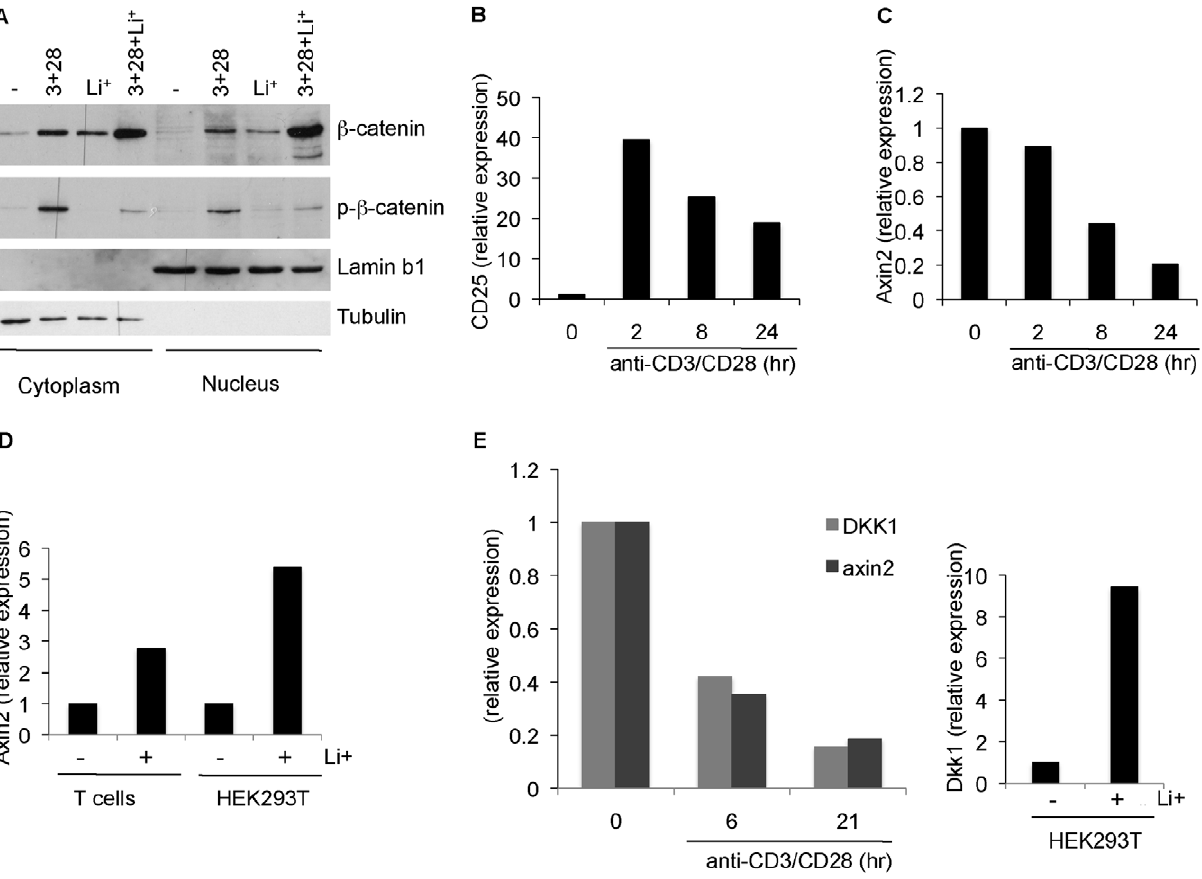
Figure 4. TCR stimulation leads to nuclear translocation of b -catenin. (A) T cells were stimulated with plate bound anti-CD3/CD28 in the presence or absence of 20 mM LiCl for 18 hours, as indicated, following which cytoplasmic and nuclear fractions were separated. Fractions were immunoblotted for b -catenin and phospho- b -catenin expression. Cytoplasmic and nuclear fractionation was confirmed by tubulin (cytosol) and lamin-B1 (nuclear) expression. (B) T cells were stimulated with anti-CD3/CD28 magnetic beads for the indicated times. CD25 (IL-2R a ) mRNA levels were measured by qRT-PCR, using Abl1 as an internal control, to verify successful T cell activation. (C) The expression of the TCF/ b -catenin target gene Axin2 was measured by qRT-PCR following stimulation of T cells with anti-CD3/CD28 (same samples as in B). (D) In parallel to the samples in B and C, T cells and HEK293T cells were left untreated or incubated with 20 mM lithium for 7 hours and measured for Axin2 mRNA levels relative to those of Abl1. (E) Left: T cells were stimulated with anti-CD3/CD28 for the indicated times and Axin2 and DKK-1 mRNA levels were determined by qRT-PCR relative to Abl and PPIA. The expression relative to Abl1 is shown, with calculations relative to PPIA yielding comparable results. Right: HEK293T cells were left untreated or incubated with 20 mM lithium for 7 hours and measured for DKK-1 mRNA levels relative to those of Abl1. All qRT-PCR reactions were performed in triplicate.